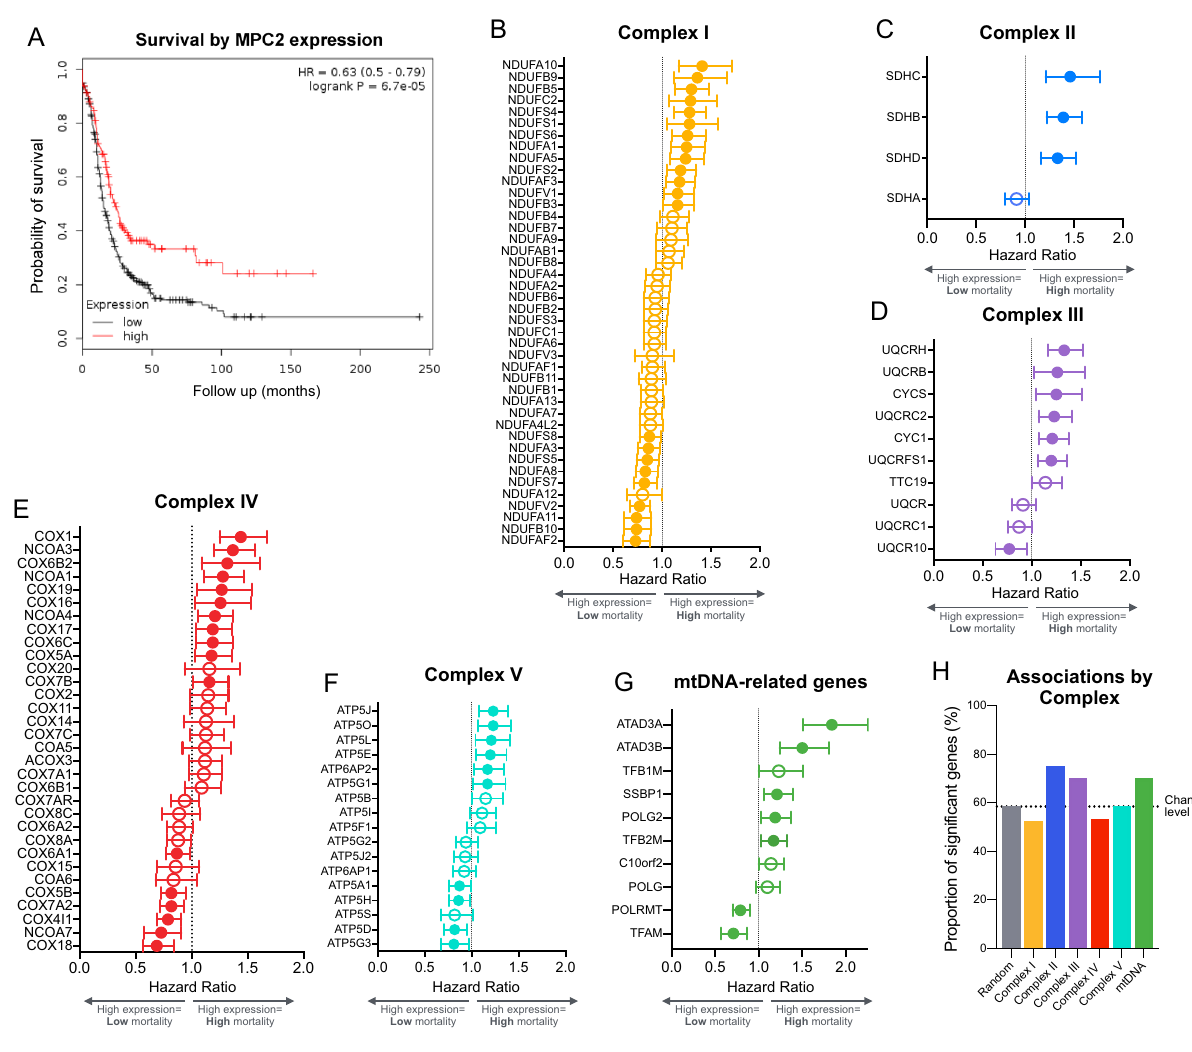
Figure 1. Expression of mitochondrial genes predict survival in ovarian cancer patients. ( A ) Kaplan Meier Plotter (KMPlot.org) survival analysis of patients with ovarian cancer exhibiting low (n = 454) or high (n = 160) gene expression for a key component of mitochondrial metabolism, the mitochondrial pyruvate carrier 2 ( MPC2 ) gene. ( B ) Hazard ratios (HR) from Kaplan Meier survival analysis shown as forest plots for genes encoding subunits of the mitochondrial respiratory chain complexes I, ( C ) II, ( D ) III, ( E ) IV, ( F ) V, and ( G ) and mtDNA-related genes. ( H) Summary of results illustrating the proportion of significant subunits in previous analysis relative to results from a randomly selected group of 200 genes. Shown are mean HR with 95% C.I. established based on the optimal cutoff; n = 614–1435 for each gene. Filled symbols are significant based on the 95%